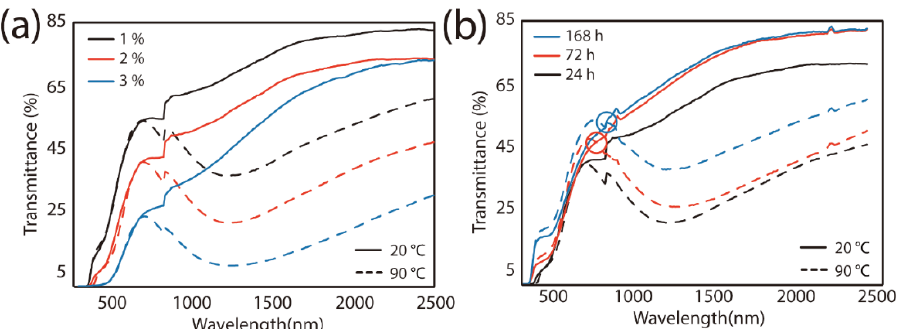
Figure 8. Transmittance spectra of fabricated VO 2 films with VO 2 nanoparticles (NPs) synthesized: ( a ) different concentrations of prepared VO 2 dispersion; ( b ) different duration of the hydrothermal samples. The circles in the figure indicate the appearance of the crosspoints.